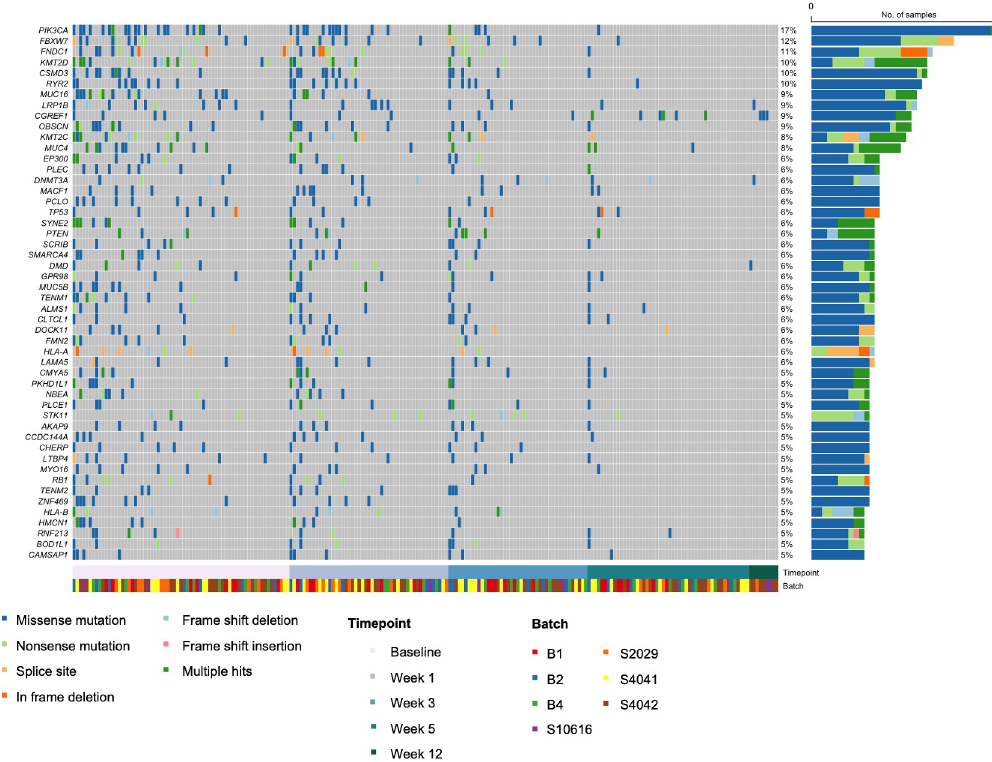
Fig 4. Top 50 gene alterations over time for 70 patients with paired normals. Heat map displaying the top 50 genes ranked by occurrence for 70 patients (216 samples) grouped by timepoint collection during chemoradiation.